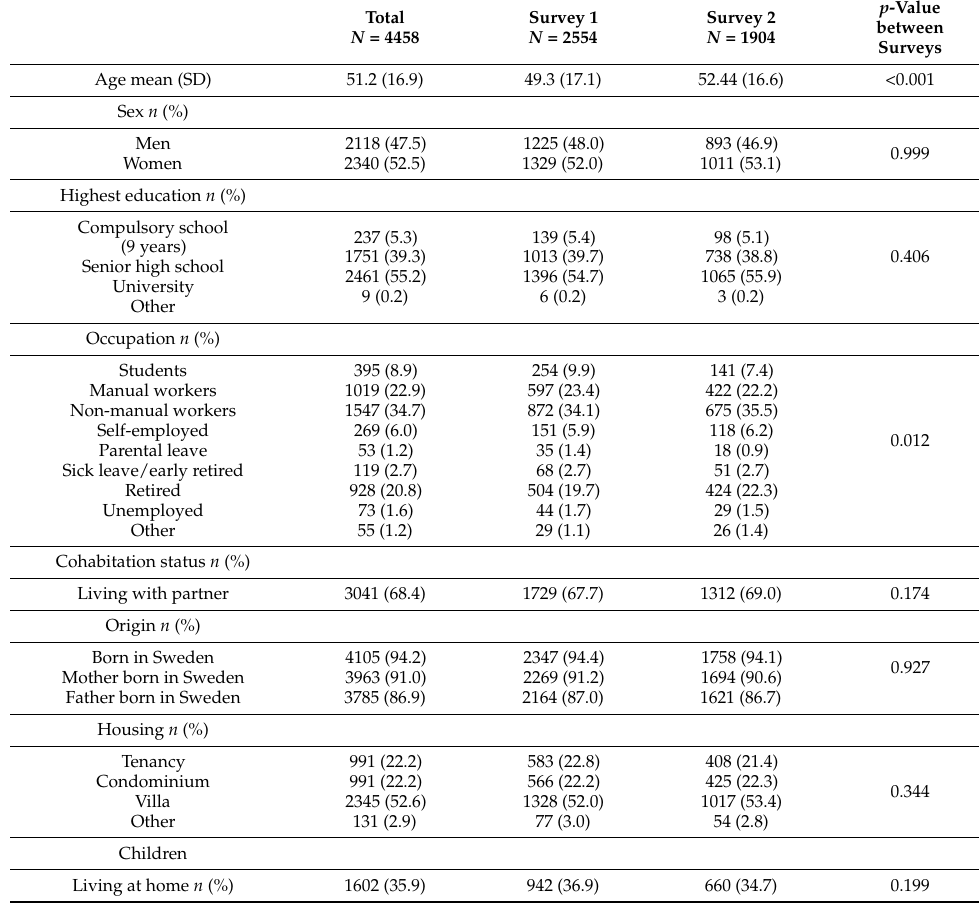
Table 1. Demographic characteristics for the two surveys.